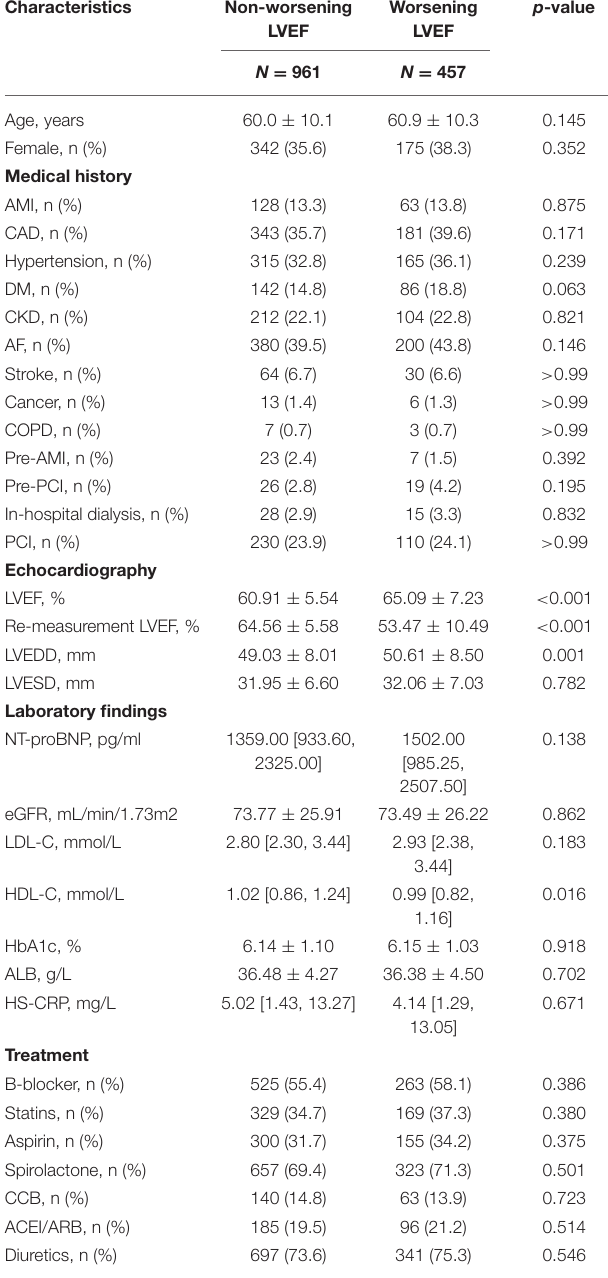
TABLE 1 | Baseline characteristics of patients with HFpEF with and without worsening LVEF. Characteristics